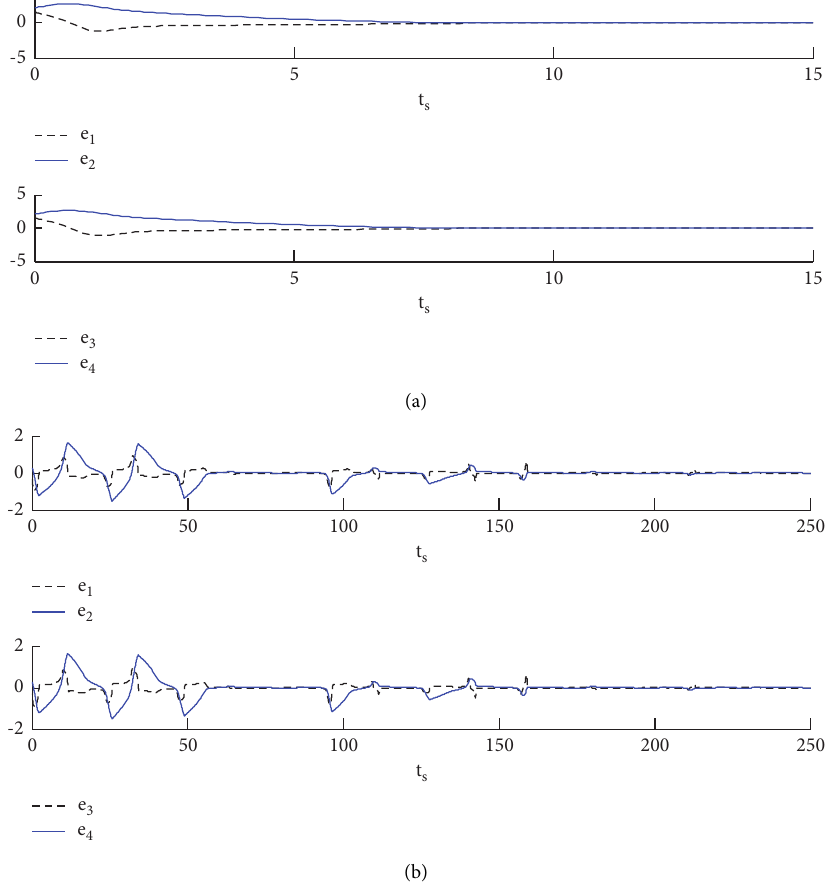
Figure 2: (a) Error between the states of the master and (b) the slave system for Theorem 1.